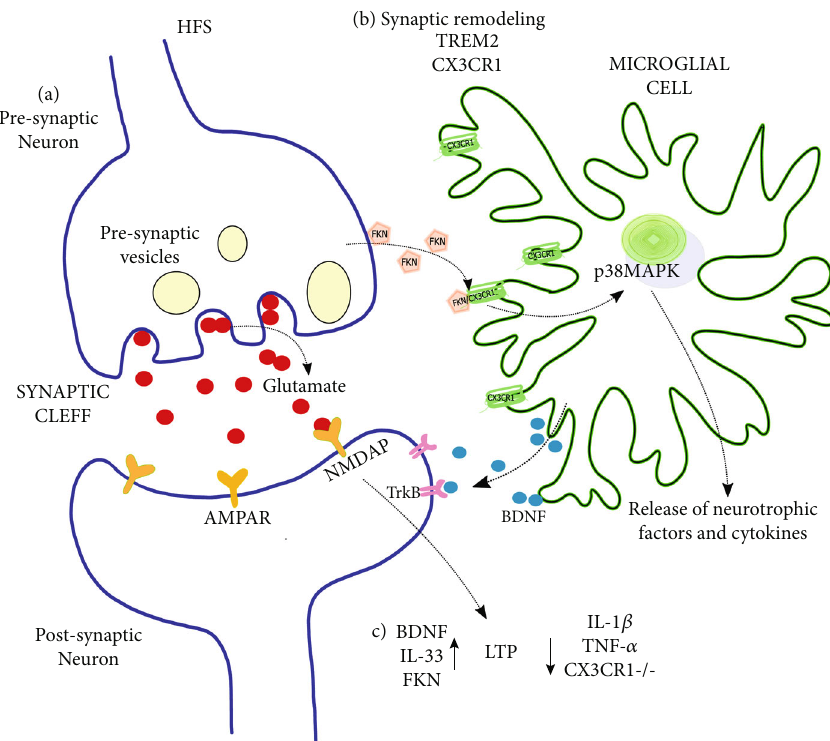
Figure 1: Microglia regulate hippocampal LTP through FXN/CX3CR1 signaling. (a) After high-frequency stimulation (HFS), increased glutamate release overactivates AMPAR but mostly NMDAR, inducing hippocampal long-term potentiation (LTP). (b) Microglia communicate with neurons through CX3CR1, inducing synapse remodeling and promoting plasticity. The lack of CX3CR1 impairs synaptic remodeling and engulfment and spine formation. (c) After HFS, neurons release FKN to activate microglial CX3CR1, leading to the synthesis and release of neurotrophic factors (BDNF) and cytokines, which can enhance ( ↑ ) or inhibit ( ↓ ) hippocampal LTP. The lack of CX3CR1 or FKN inhibits LTP, which is related to the exacerbated release of IL-1 β and TNF- α